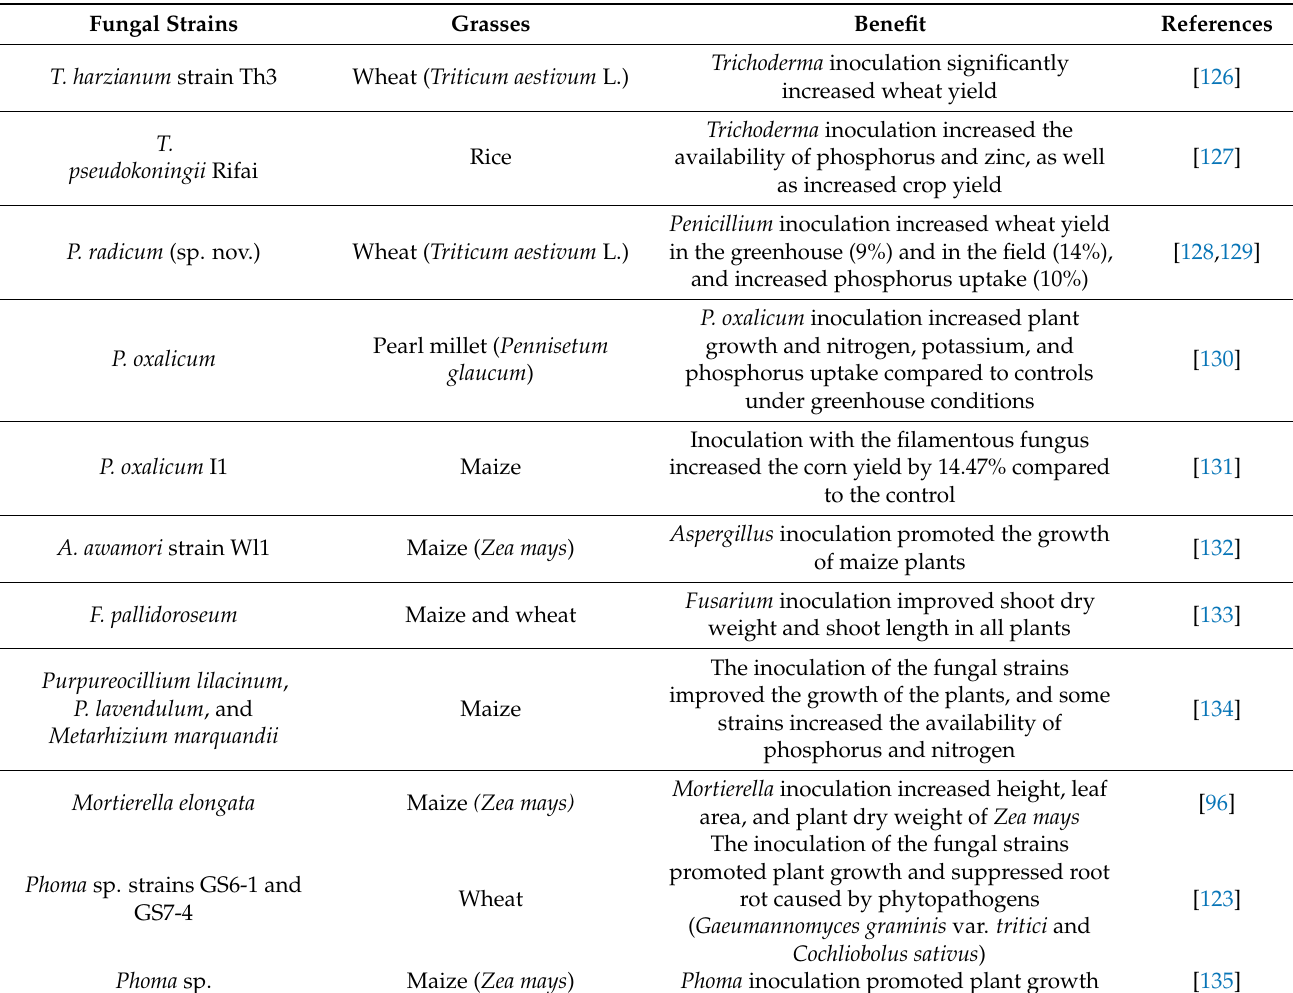
Table 1. Filamentous fungi that promote the growth of